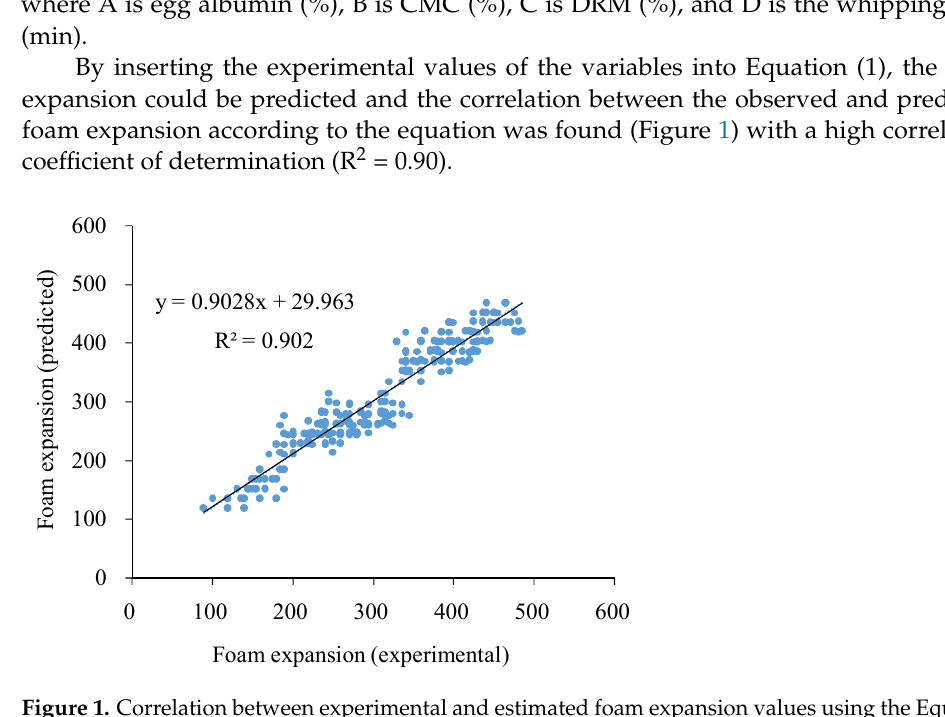
Figure 1. Correlation between experimental and estimated foam expansion values using the Equation (1) model.